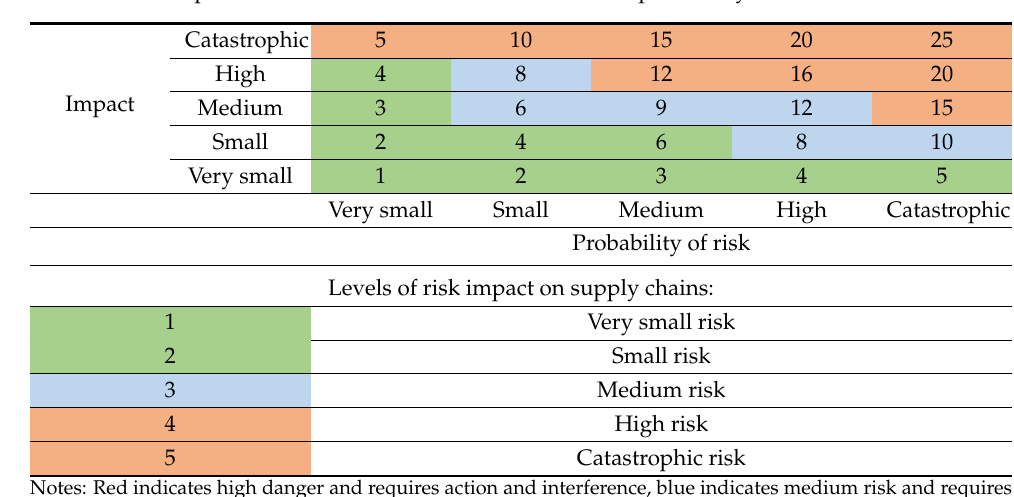
Table 3. Risk map scheme filled with numerical values of the probability of risk